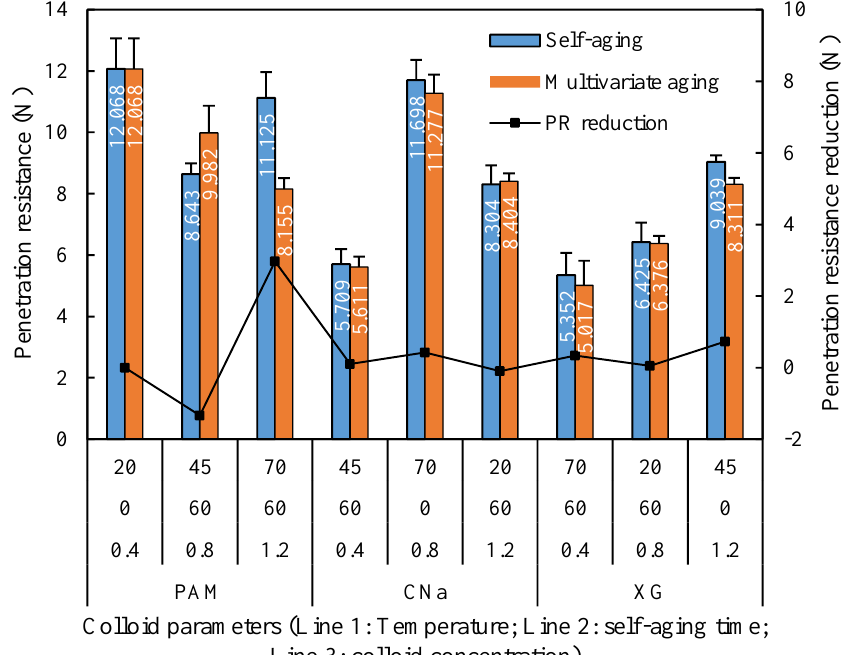
Figure 10. Temperature aged penetration resistance reduction for individual application.